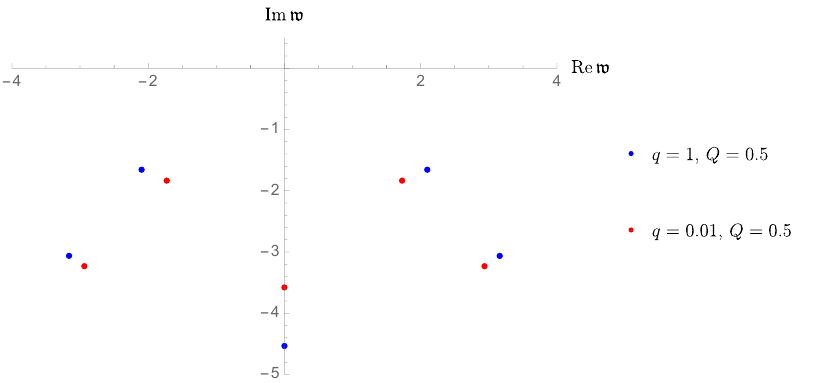
Figure 6. The four lowest complex quasi- normal modes and the lowest purely imagi- nary one in the spin 1 channel, at q = 1. Ev- ery colorful path-like set of points, starting in purple and ending in red, shows the change of one speci(cid:12)c mode when Q discretely in- creases from 0 : 45 to 0 : 8. We have considered 8 regular steps by increments of (cid:1) Q = 0 :